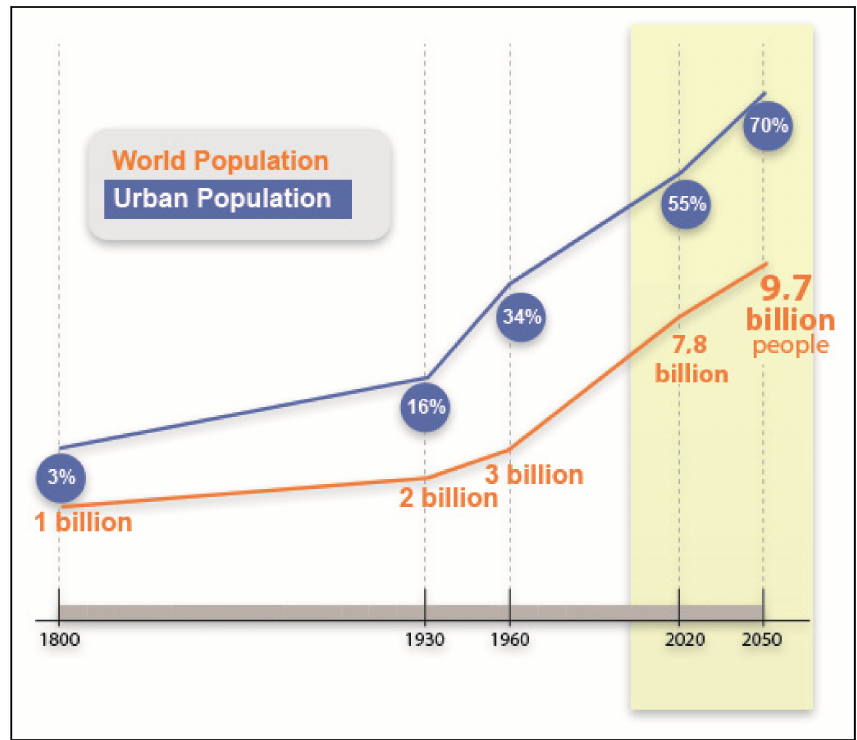
Figure 1. World population (past – present – future projections) Source: [4]. Adapted by the author.